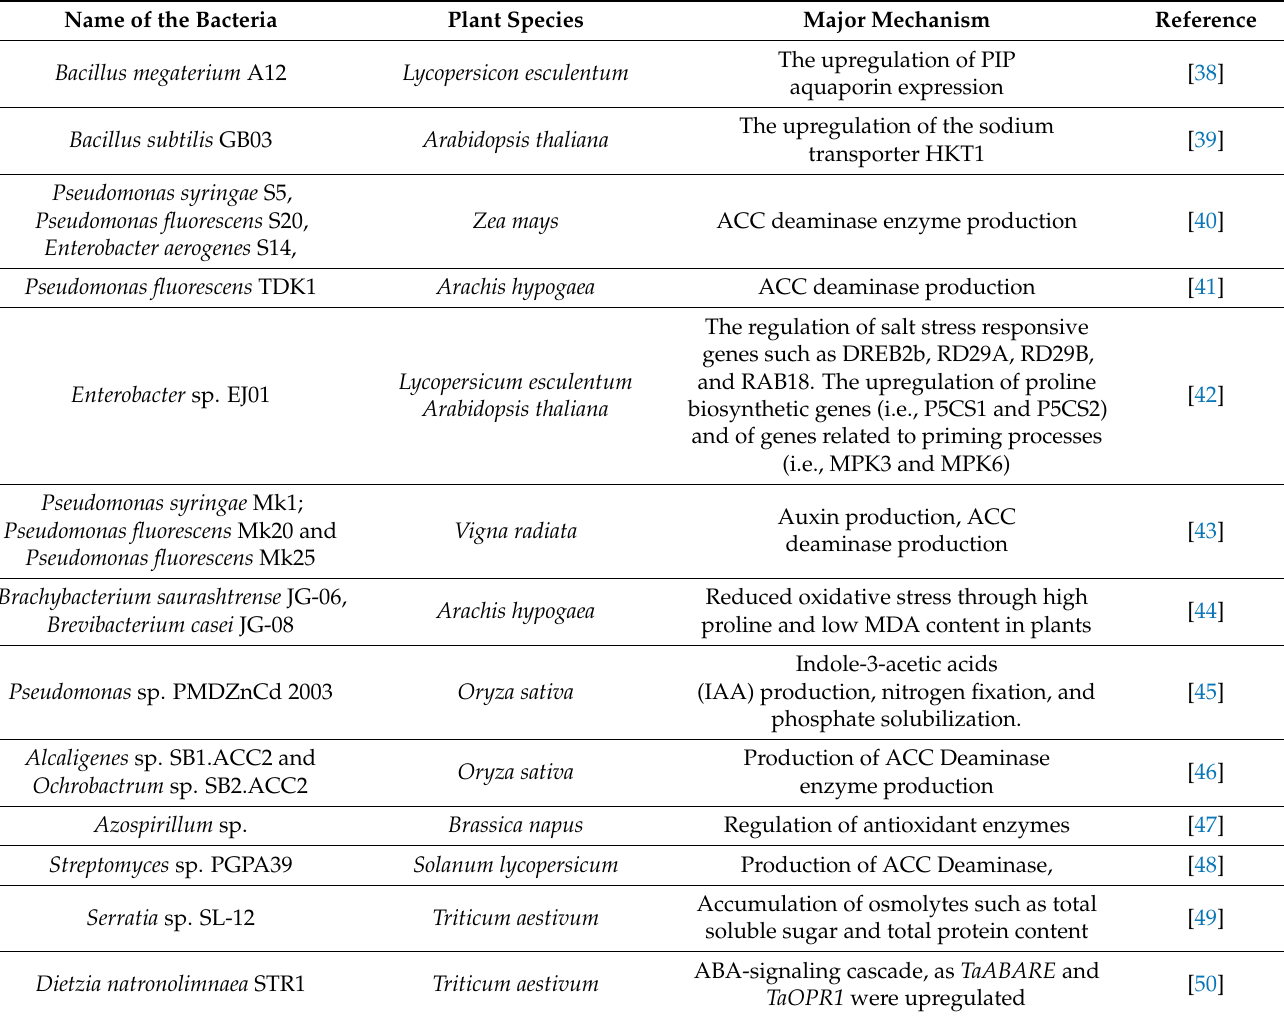
Table 1. The salt-tolerant bacteria with its mechanisms of salt-stress reduction in different